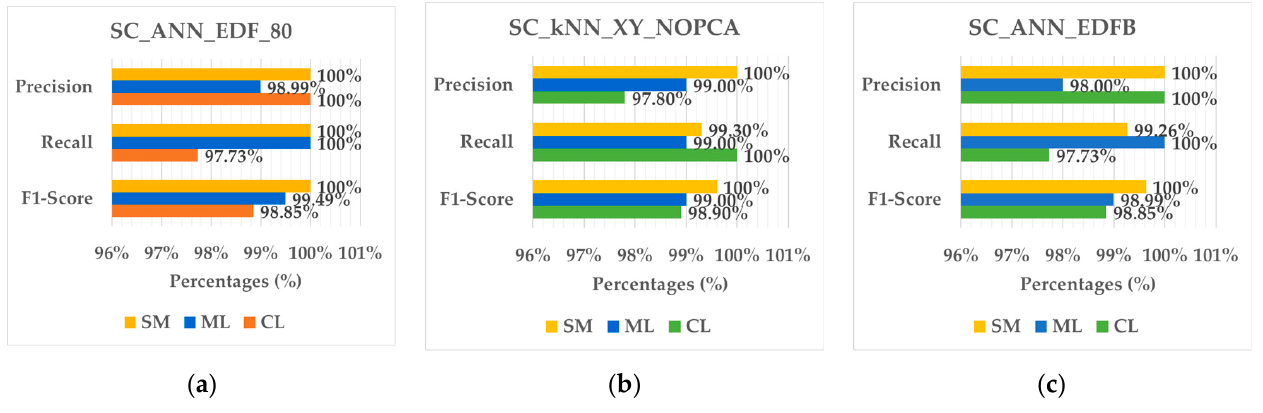
Figure 10. Precision, recall, and F1 score for every soil class from ( a ) SC_ANN_EDF_80, ( b ) SC_ANN_XY_90, and ( c ) SC_ANN_EDFB models.